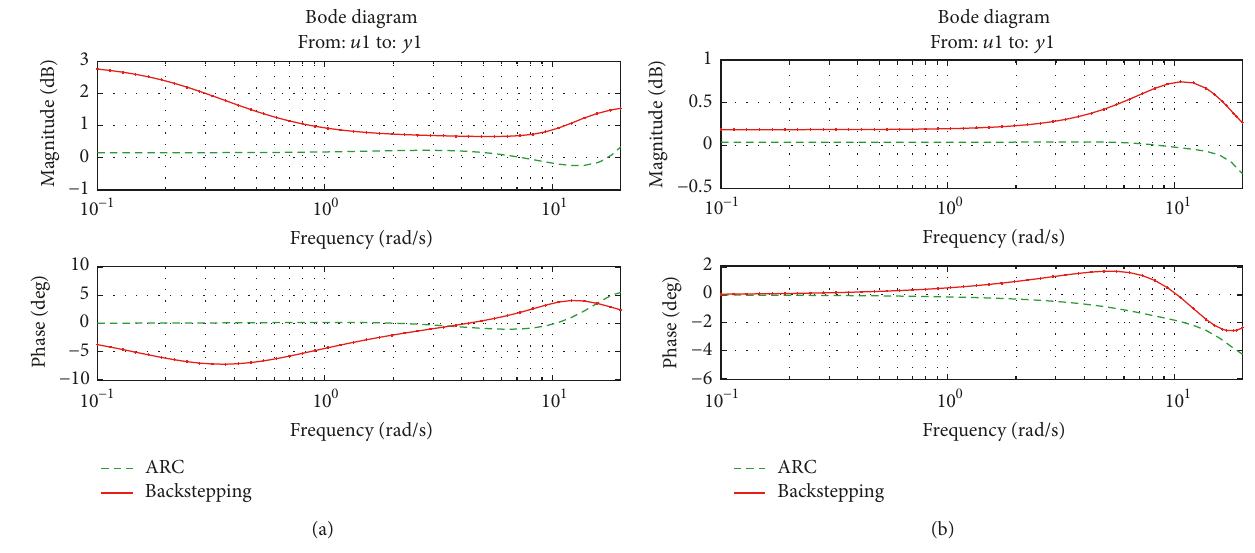
Figure 7: Tracking performance of different mass: (a) 𝑚 = 1300 kg; (b) 𝑚 = 1500